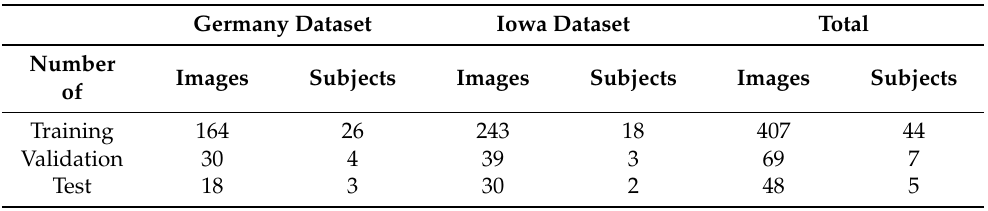
Table 1. Training dataset low-resolution and high-resolution brainmask